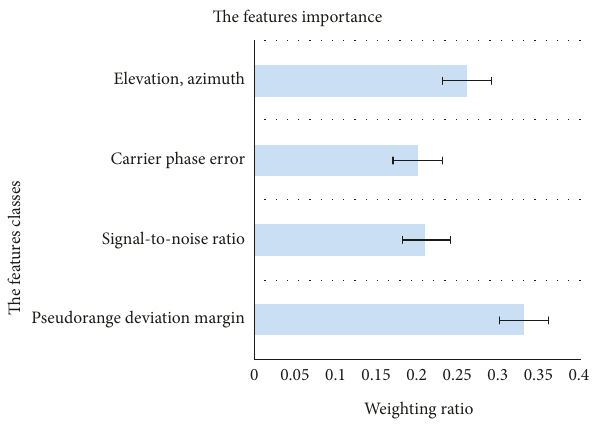
Figure 5: The features